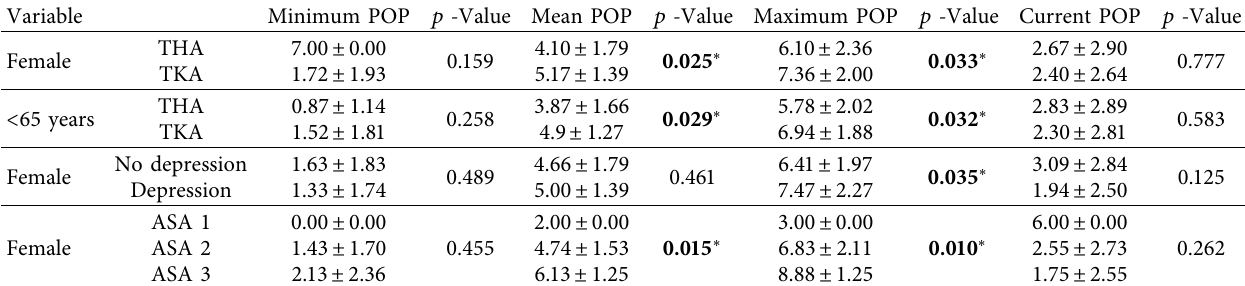
Table 3: Comparison of postoperative pain in females and younger patients ( n � 95).